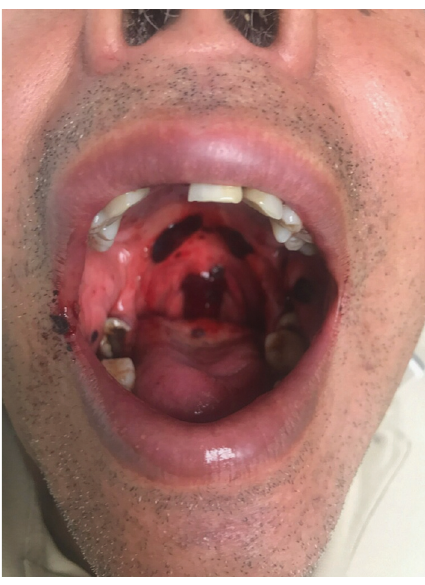
Figure 1: Significant gingival and oral mucosal